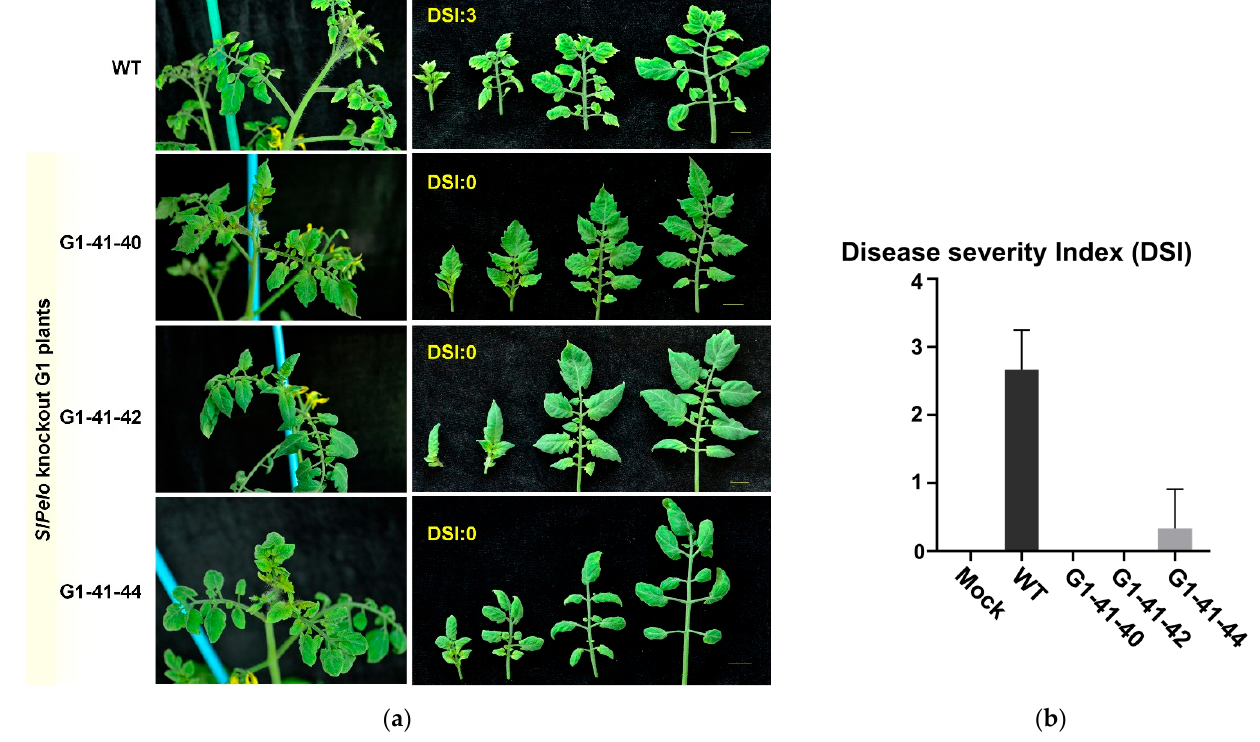
Figure 4. TYLCV-resistant phenotypes of CRISPR/Cas9-edited tomato plants. ( a ) TYLCV-inoculated wild-type (WT) and SlPelo -knockout plants were evaluated for TYLCV disease symptoms; ( b ) Disease Severity Index (DSI) was calculated for WT and SlPelo -knockout G1 plants (G1-41-40, G1-41-42, and G1-41-44). The photos were taken 28 days post-infection.